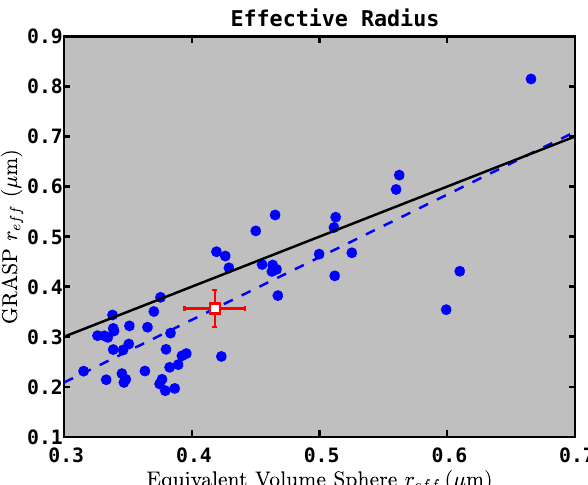
Figure 9. GRASP effective radius (subsampled to an equivalent solar zenith angle of 50 ◦ ) vs. APS equivalent-volume effective radius using variable dynamic shape factors or densities for the conversion from aerodynamic size to equivalent volume size. Red square and error bars represent means and two standard deviations of the means for the blue points. Solid line is 1:1 and dashed line represents linear regression; see Table 3 for regression statistics.